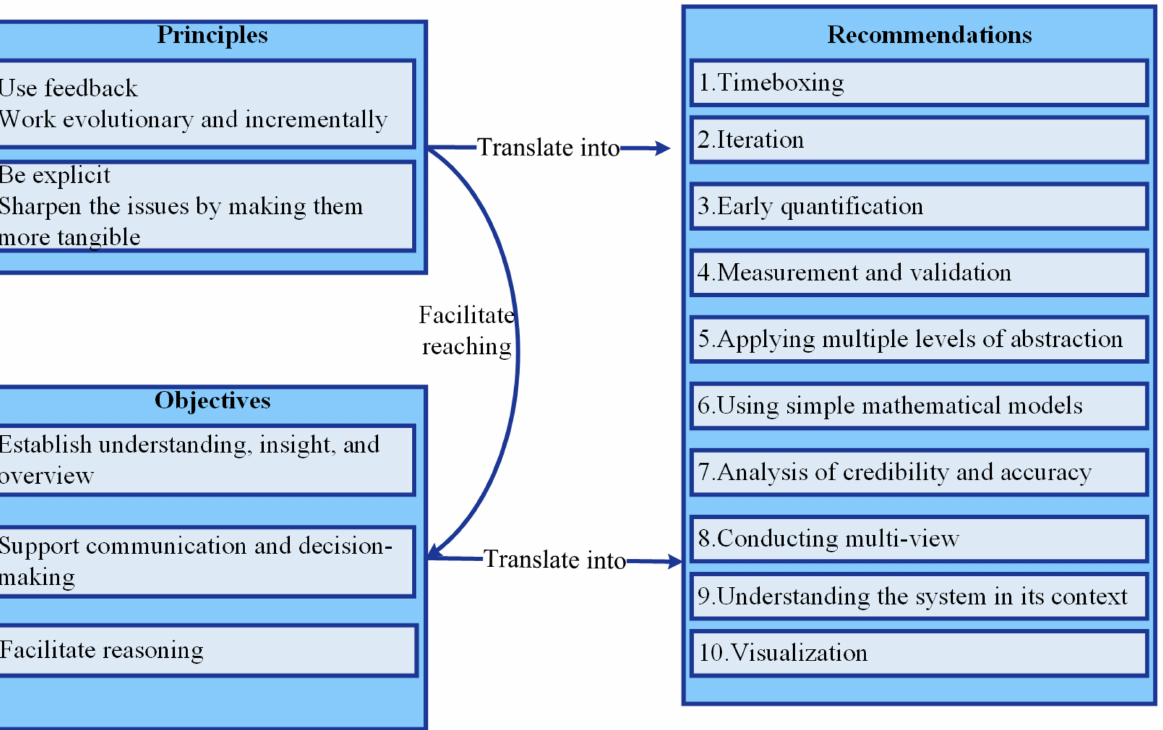
Figure 5. Recommendations, accompanied with its principles and objectives, modified from